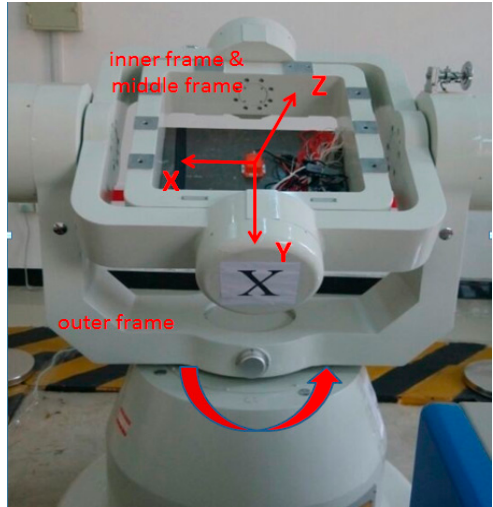
Figure 4. Installation of Micro-Electron-Mechanical System (MEMS) IMU on tri-axial rotation table.